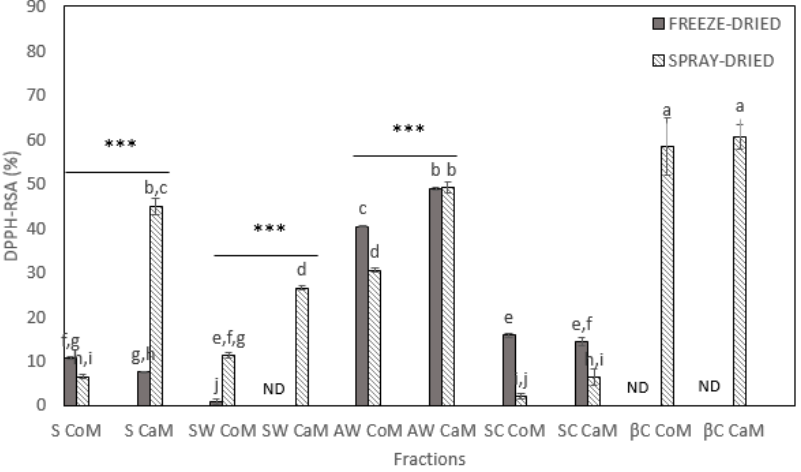
Figure 3. Antioxidant activity by radical scavenging activity (DPPH assay) of non-irradiated